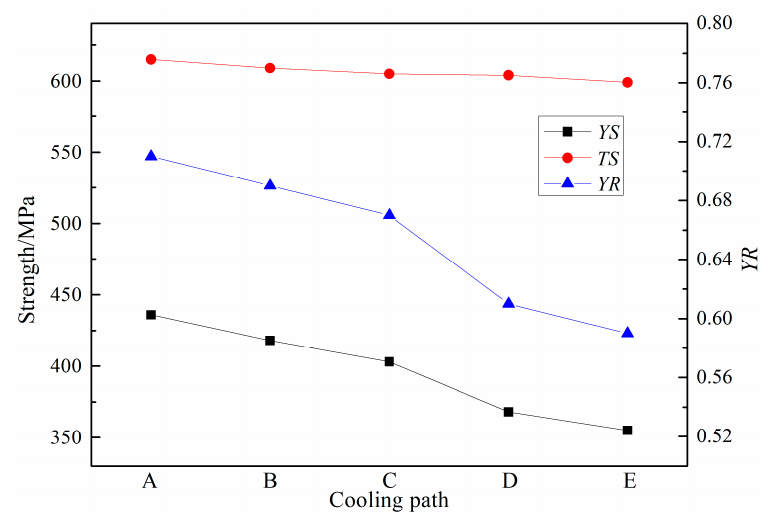
Figure 4. Tensile properties of the different CP samples.